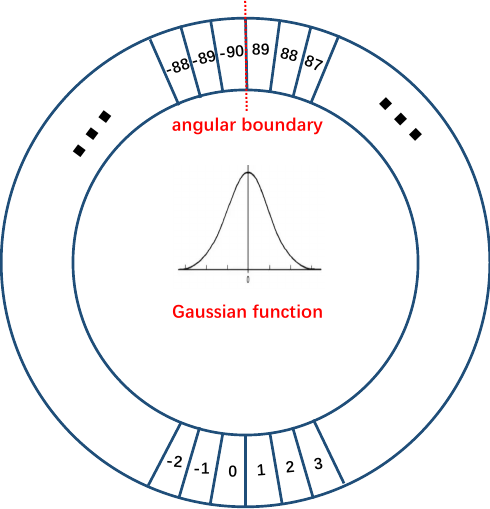
Figure 5. Visualization of the circular smooth